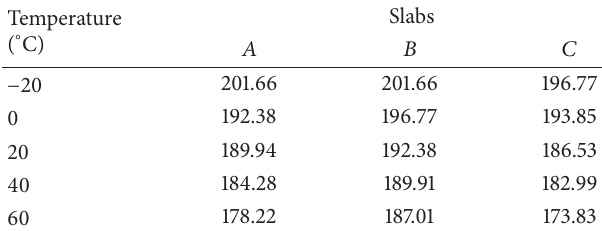
Table 5: First order natural frequency for intact concrete slab.